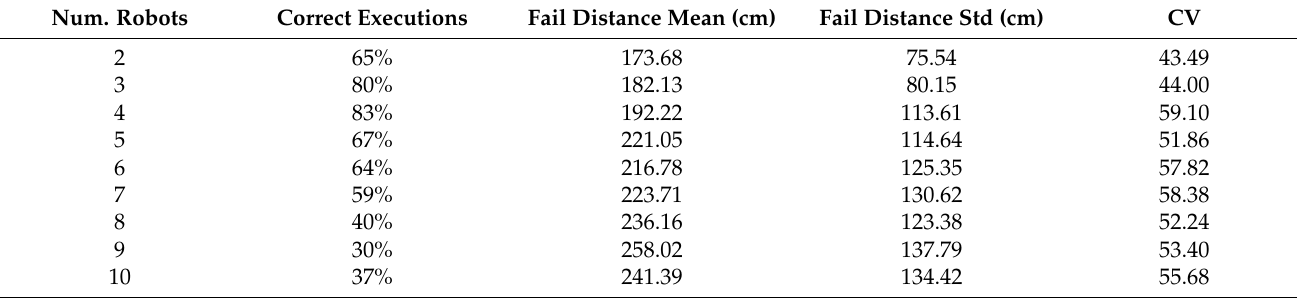
Table 4. Scalability tests. For each swarm size, 100 executions of the behavior were carried out. If the box did not reach the goal in 700 iterations, then the test was marked as incorrect. For all incorrect tests of each size, the box–goal mean distance, the standard deviation and the coefficient of variation ( CV = ( std / mean ) × 100 ) are shown. Num.